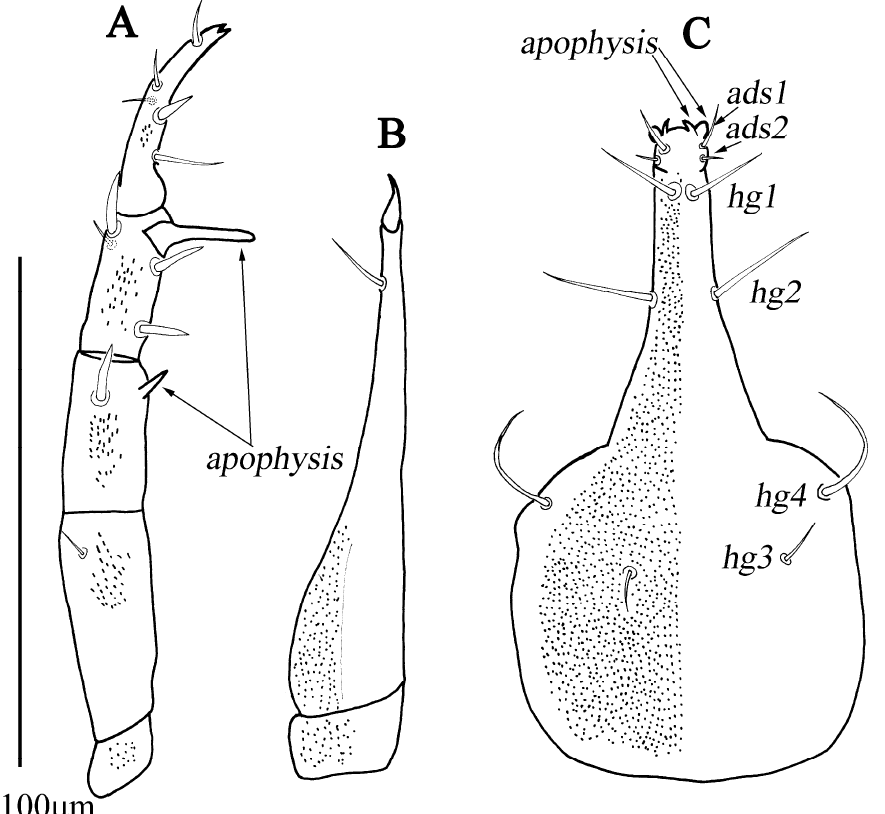
Figure 20. Brevicaudus trapezoides sp. nov. (male). ( A )—Palp. ( B )—Chelicerae. ( C )—Subcapitulum. Scale bar = 100 µm.